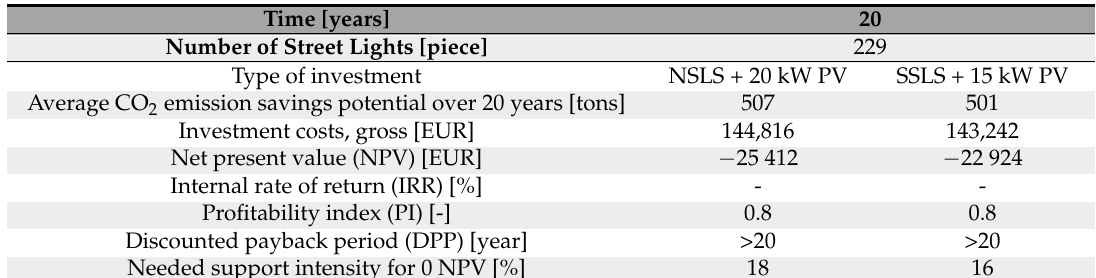
Table 5. Overall investment-efficiency indexes: street lighting development including PVS.